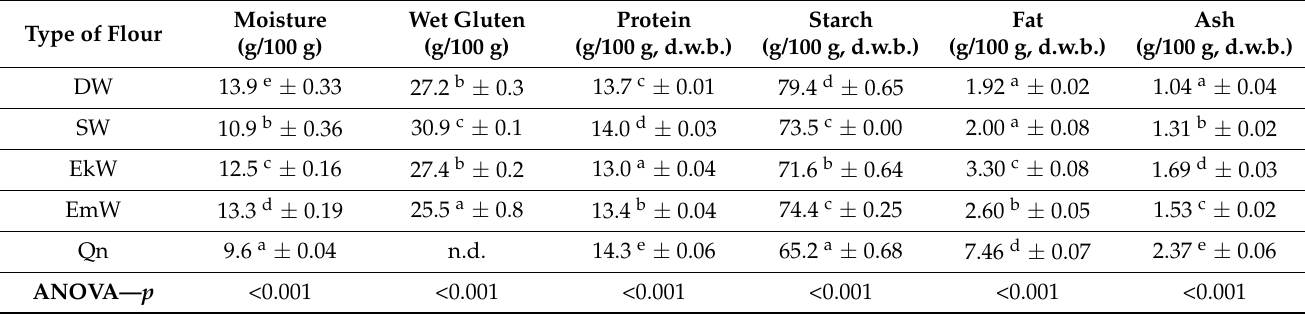
Table 1. Proximate composition of flours.